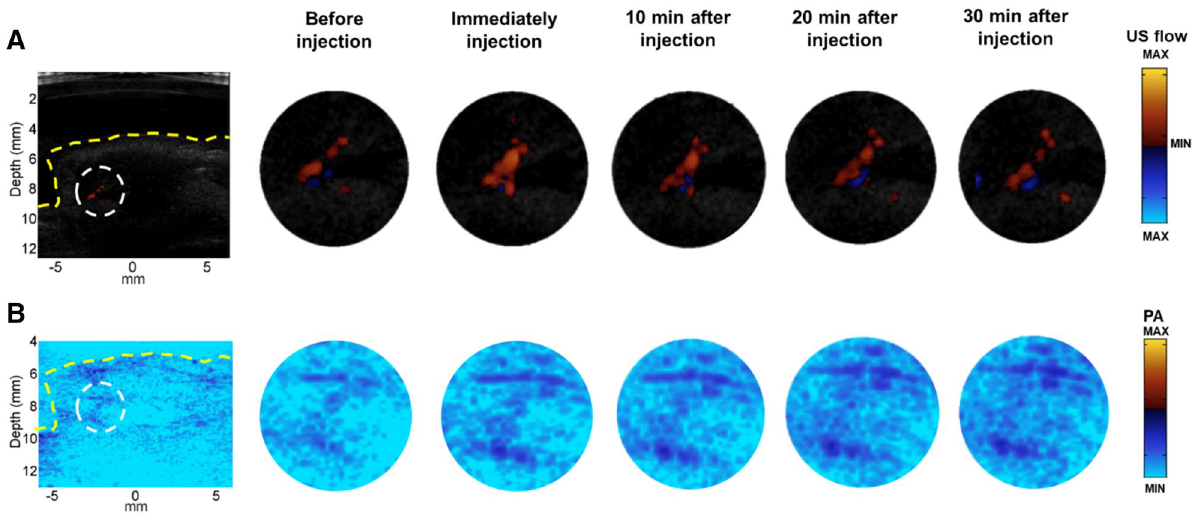
Figure 6. US flow ( A ) and PA ( B ) images of the subcutaneous tumor. The yellow dashed curves indicate the outline of the tumor. White dashed circles are the areas evaluated